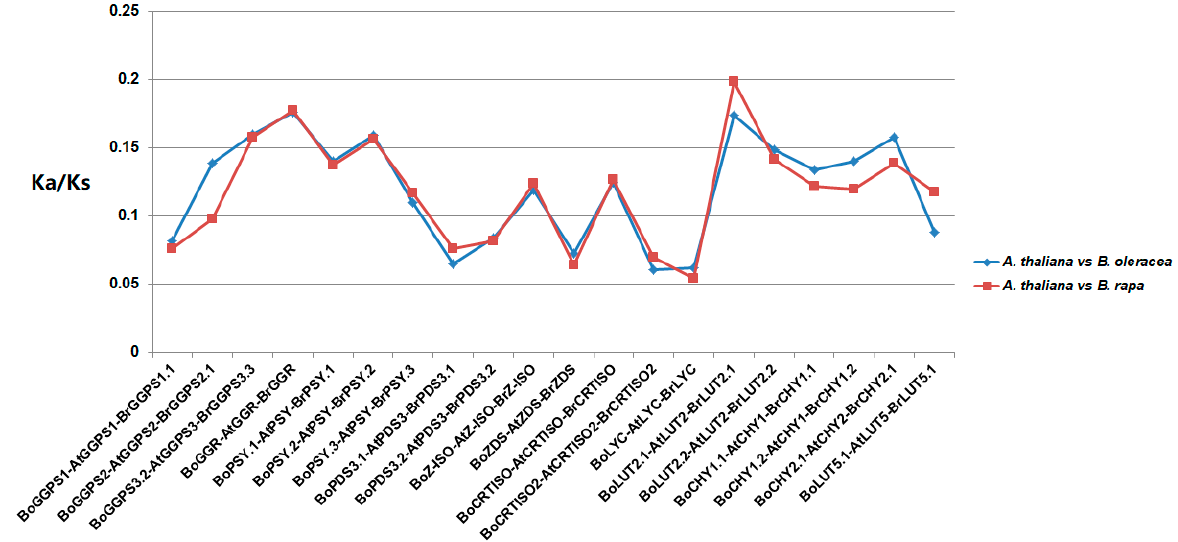
Figure 3. Ka/Ks values of orthologous gene pairs for carotenoid biosynthetic genes among A. thaliana , B. oleracea and B. rapa .